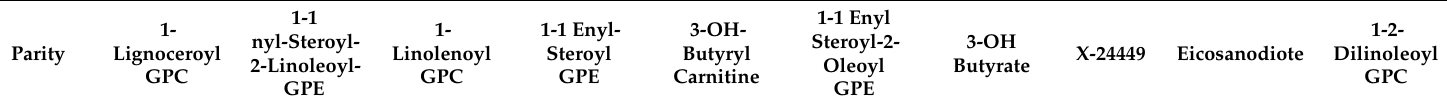
Table 6. Pairwise correlation analysis for selected metabolites with age and